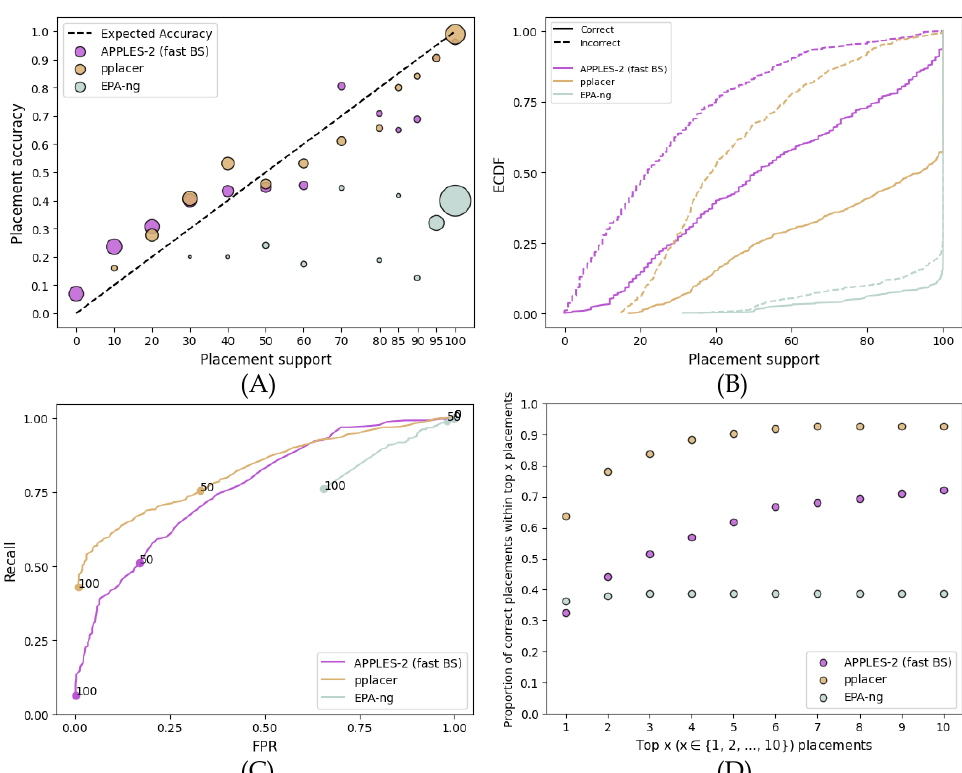
Figure 3. Results for the RNASim simulated fragmentary 200 bp dataset. ( A ) Support vs. Accuracy, ( B ) ECDF, ( C ) ROC curves, ( D ) Frequency of correct placements within the top 1 ≤ x ≤ 10 highest support placements. MSE among support ≤ 70%: 0.01 for APPLES-2, 0.009 for pplacer, and 0.09 for EPA-ng; among support > 70%: 0.02 for APPLES-2, 0.002 for pplacer, and 0.37 for